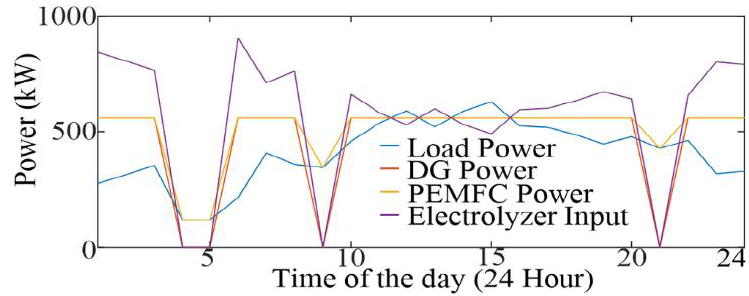
Figure 10. Power generation and consumption for one day: combination